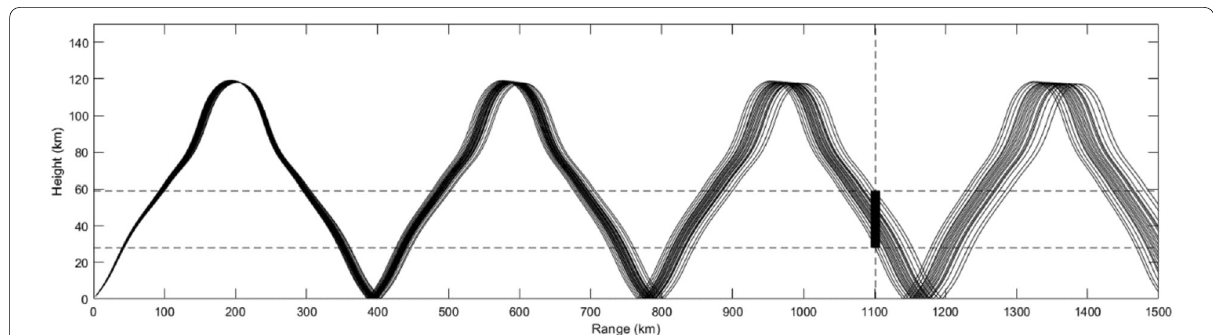
Fig. 6 Back-projection reconstruction of the ray trajectories of the signal at 00:14:23 recorded at the infrasound station in Yunnan Province